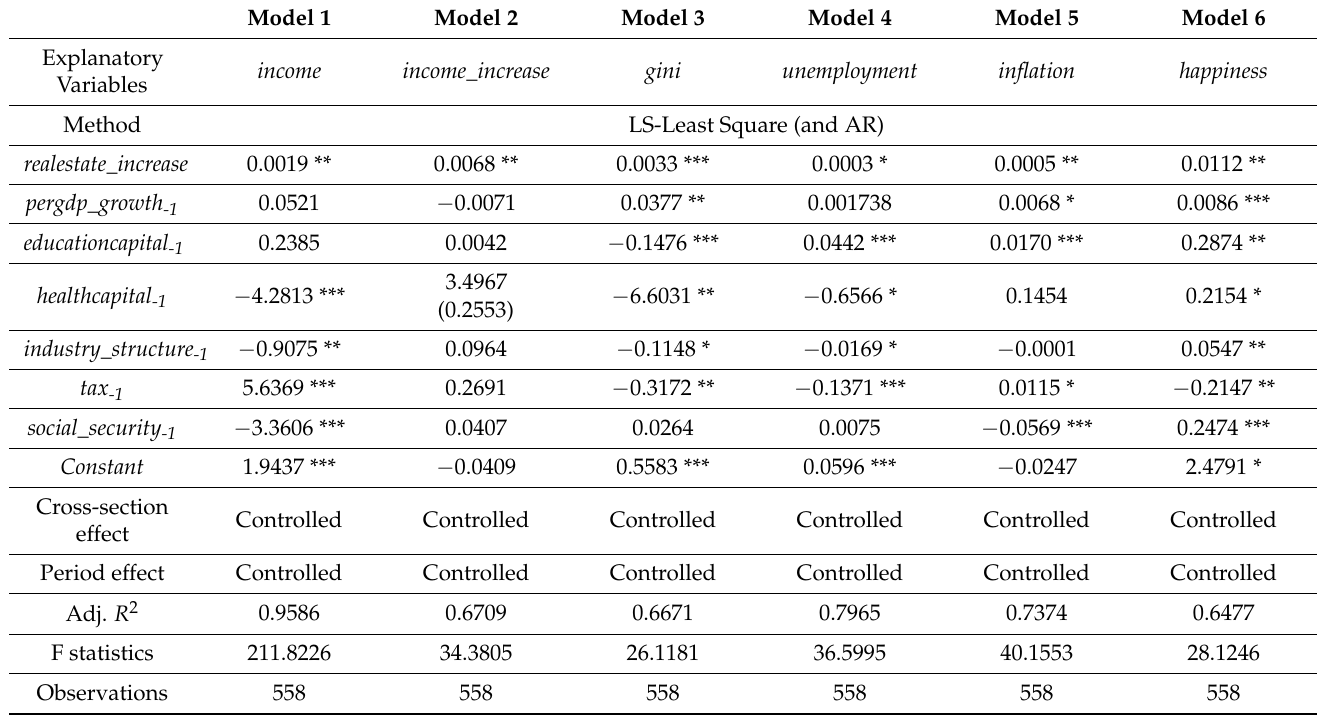
Table 1. LS test of real estate investment growth on national